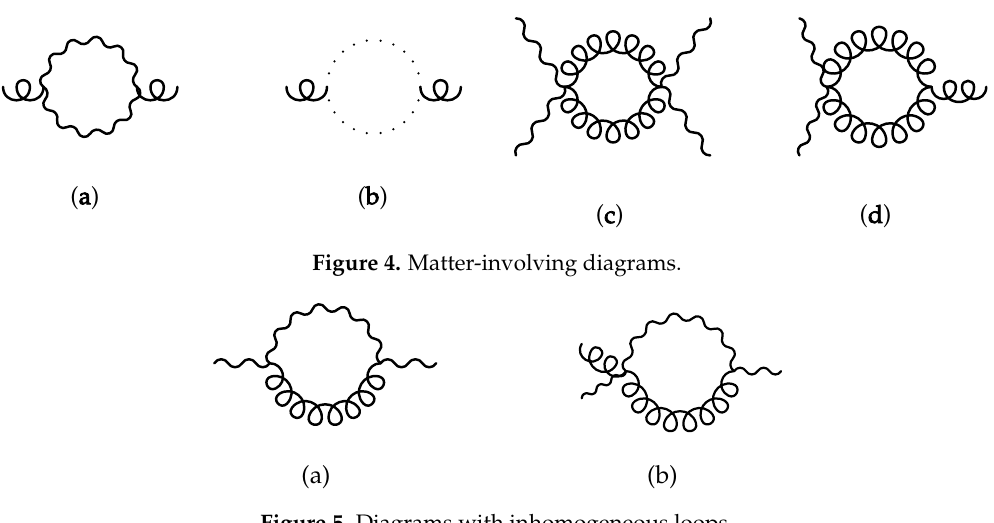
Figure 5. Diagrams with inhomogeneous loops